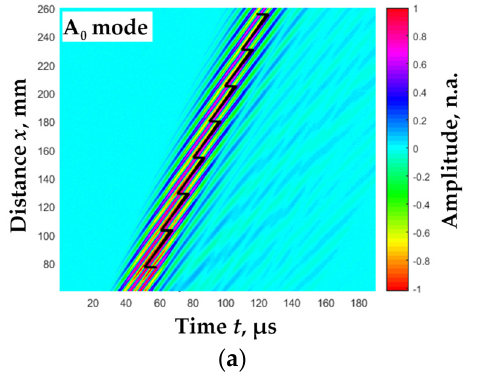
7) with the frequency bandwidth ratio R = 3 were selected. The resonant frequency of the central filter was f 4 = 161.15 kHz and the distance between the filters was df = 7.68 kHz. Figure 9. B-scan image of the A 0 mode propagating through an aluminum plate at a test distance of 60 to 260 mm from the excitation point ( a ), the signals u ( x 1 , t ) and u ( x 2 , t ) at the distances x 1 = 80 mm and x 2 = 220 mm ( b ) and the frequency responses (FR) of these signals ( c ).